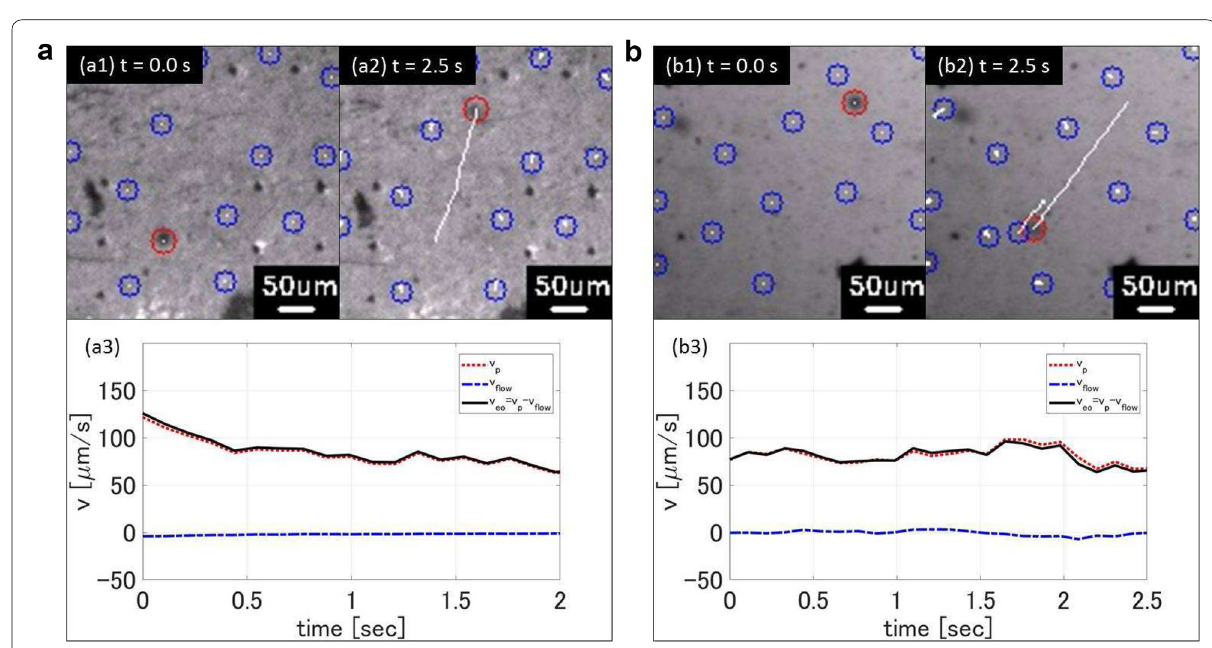
Fig. 6 Self-propulsions of the two fastest 10 μm prototypes in a glucose solution. a The fastest prototype. b Another prototype. These were processed in the same way as Fig. 5b. Additional files 1 and 2 are the movies of experiments corresponding to a and b ,